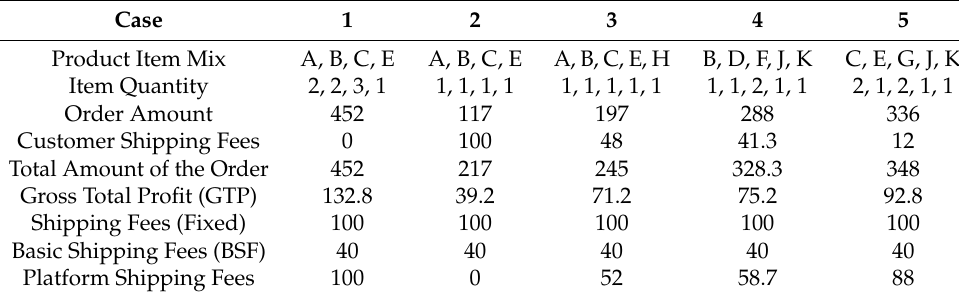
Table 2. Different simulated purchase order scenarios.